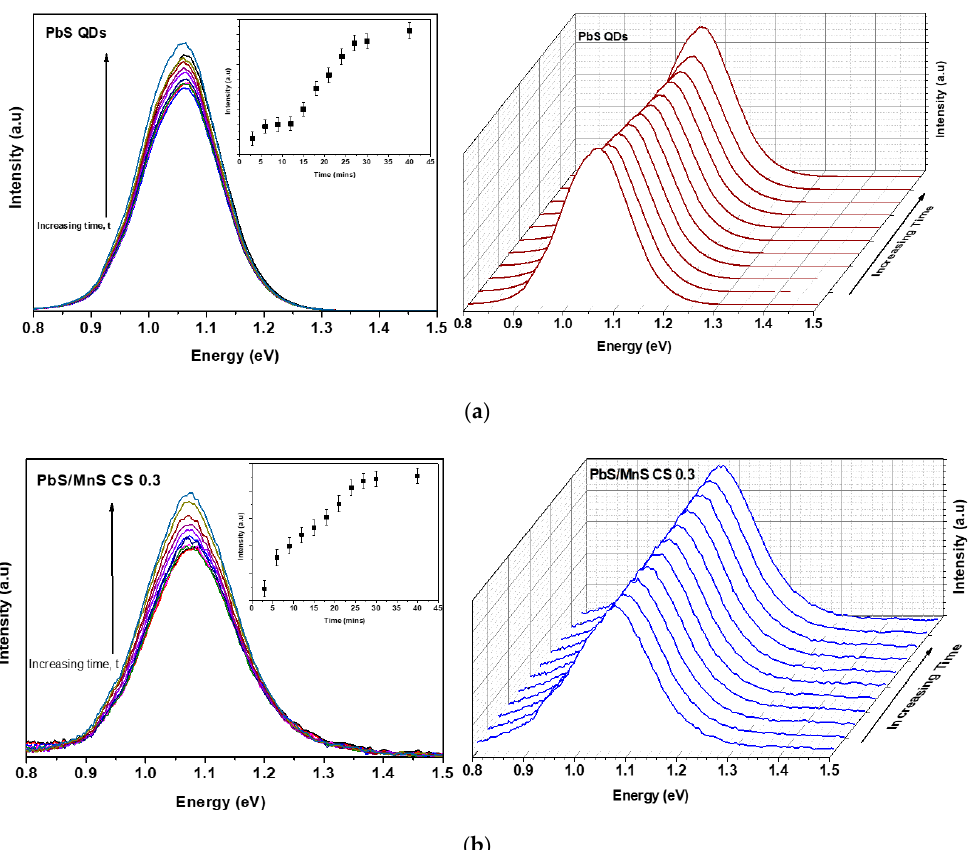
Figure 4. PL spectra of PbS core QDs ( a ) showing enhancement of PL intensity, including the intensity trend over time (inset). PL spectra of PbS/MnS CS 0.3 ( b ) exposed to laser of power P = 100 mW and time exposure for 40 min at room temperature.